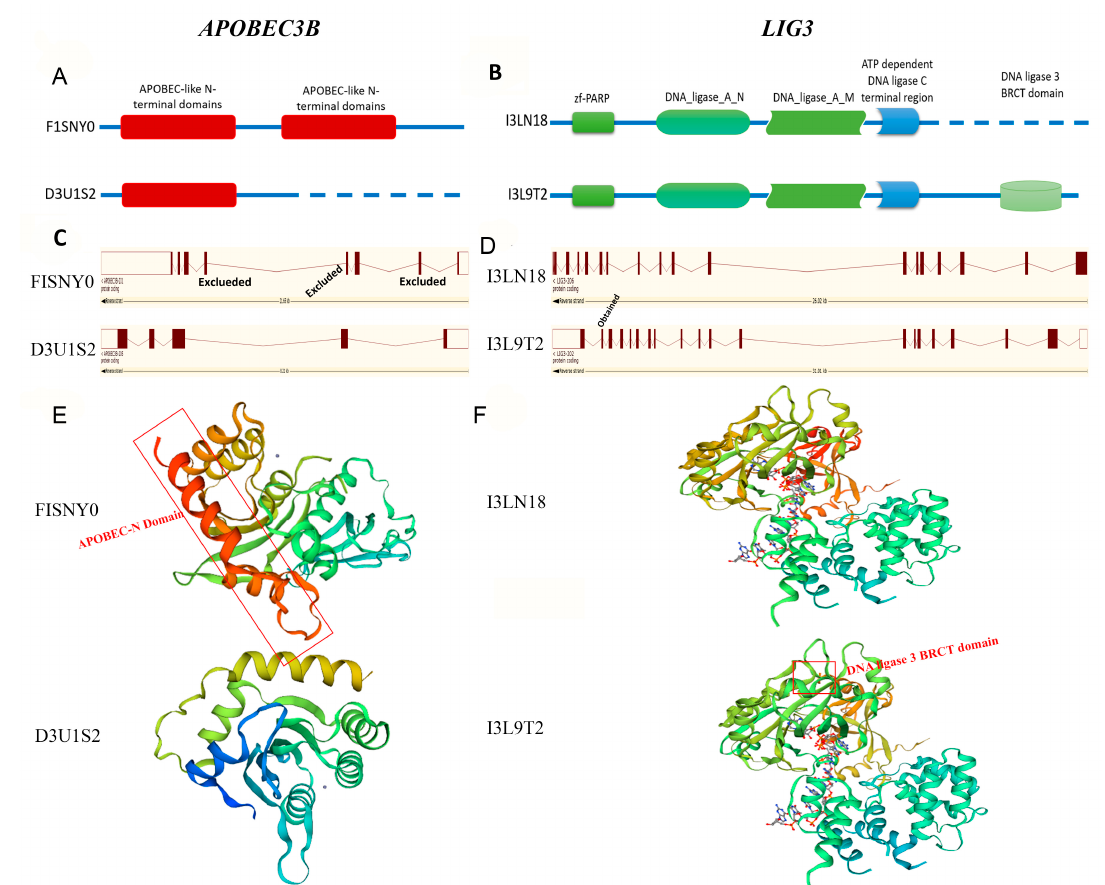
Figure 4. Examples of proteins encoded by known transcripts compared with those encoded by novel transcripts. ( A ) Apolipoprotein B MRNA editing enzyme catalytic subunit 3b (APOBEC3B)’s loss of an APOBEC-like N-terminal domain. ( B ) DNA ligase 3 (LIG3)’s gain of a DNA ligase 3 BRCA1 C-terminal (BRCT) domain. ( C , D ) The number of coding exons of APOBEC3B and LIG3. ( E , F ) The predicted protein conformations of APOBEC3B and LIG3.